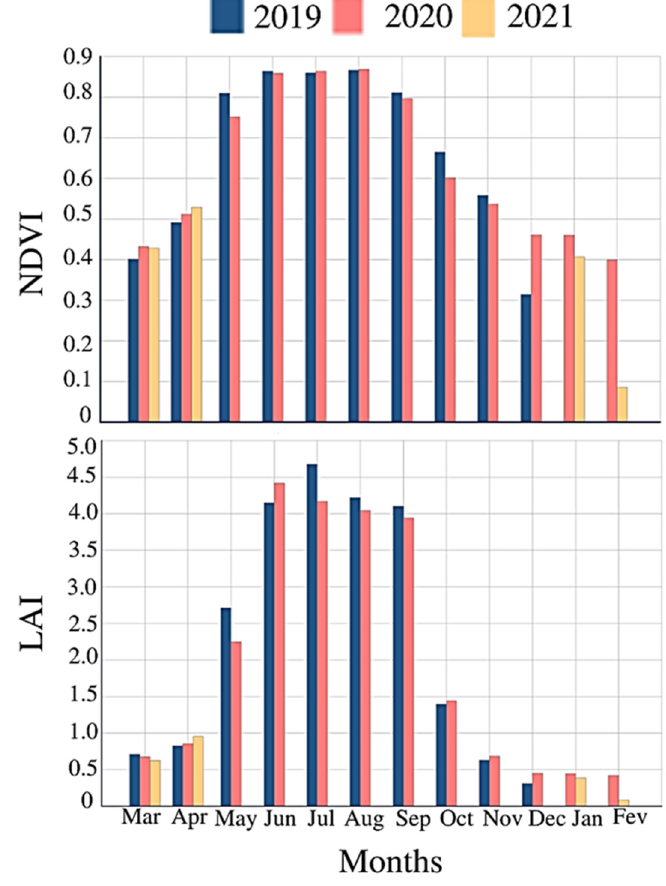
Figure 3. Monthly variation of NDVI ( top ) and LAI ( bottom ) over the Millbrook site during the SMAPVEX19-22 period.